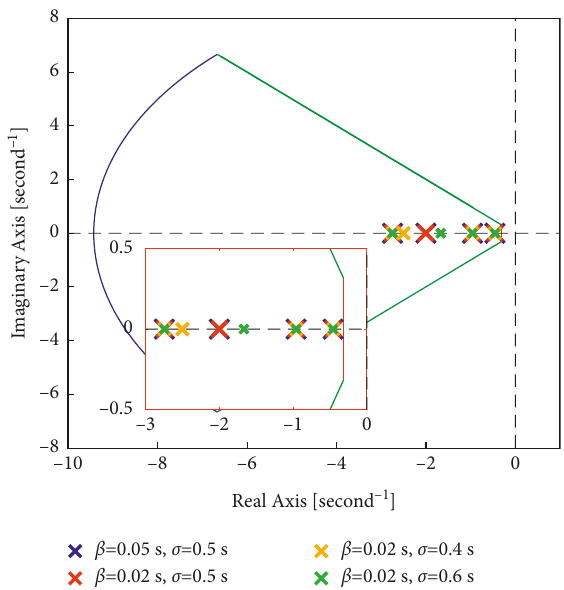
Figure 9: The pole distribution of different